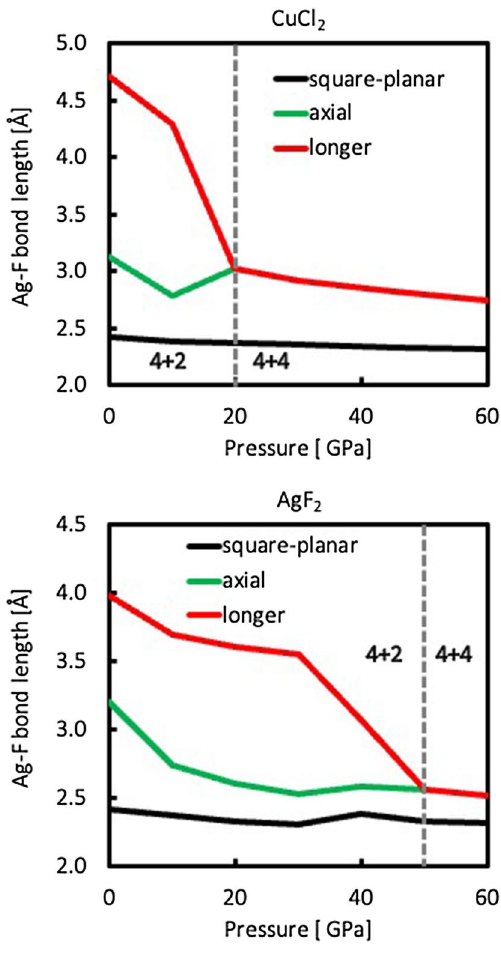
Figure 6. Pressure dependence of Ag-F distances in CuCl 2 -type and AgF 2 -type polymorphs in the HSE06